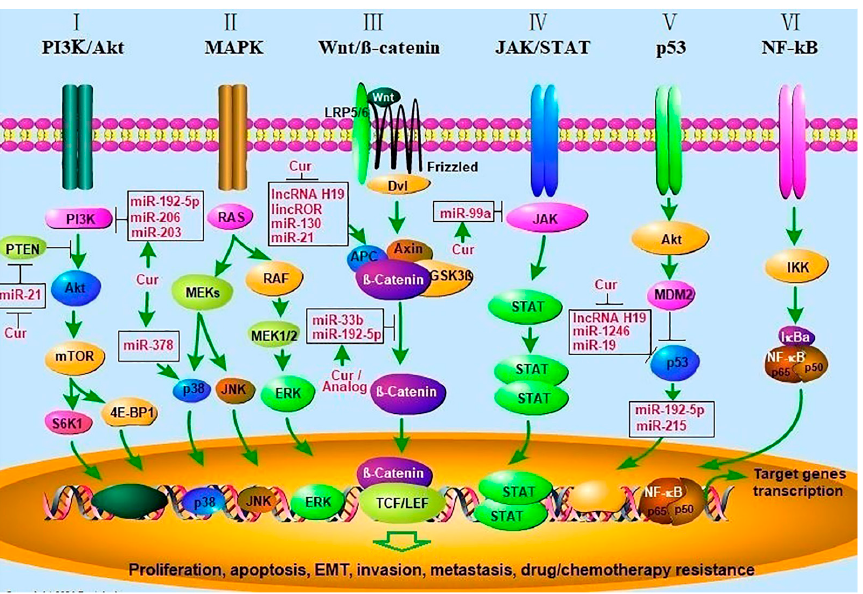
Figure 1. Curcumin inhibits cancer progression by regulating many signal pathways. (I) Akt/PI3K/mTOR signaling pathway. PTEN inhibits Akt activation by PI3K, mTOR phosphorylates p70S6K1 (S6K1), and 4E‑BP1 which activate cell growth and survival pathways. Curcumin inhibits the Akt/PI3K/mTOR pathway by increasing PTEN expression through